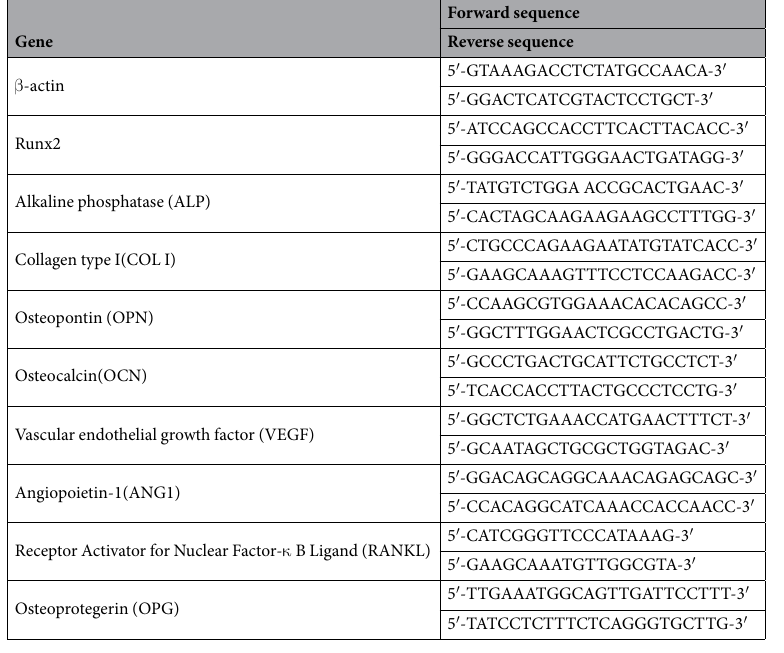
Table1. List of primers used and their respective forward and reverse